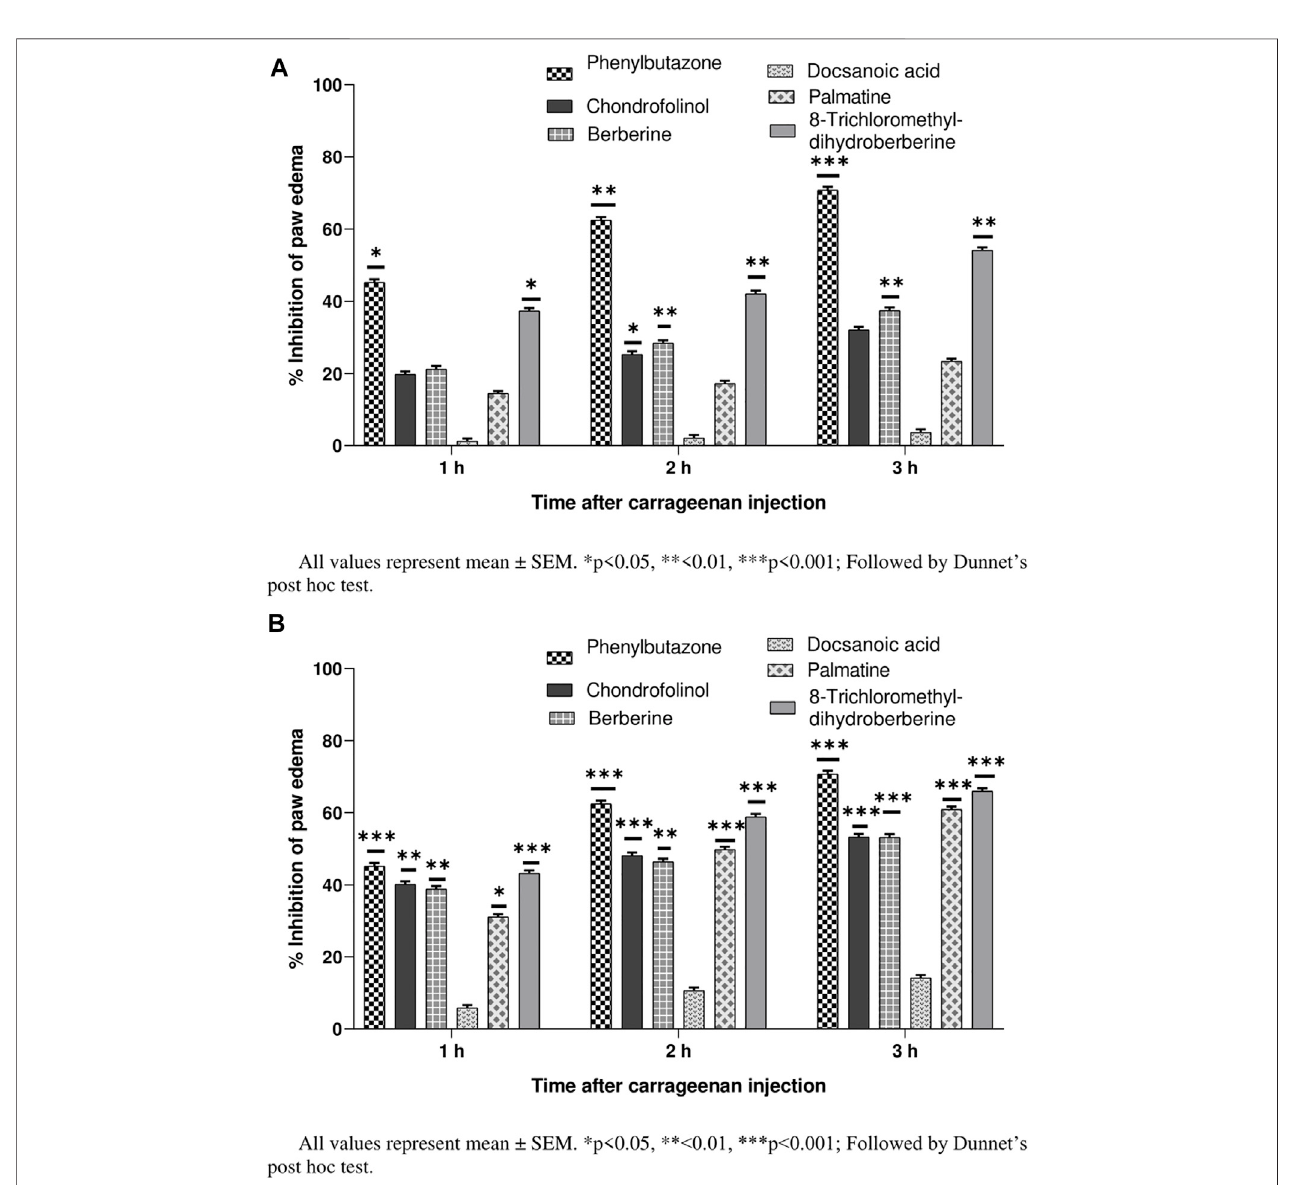
FIGURE 2 | (A) Anti-in fl ammatory potential of compounds 1-5 at 10 mg/ kg. (B) Anti-in fl ammatory potential of compounds 1 – 5 at 20 mg/ kg.